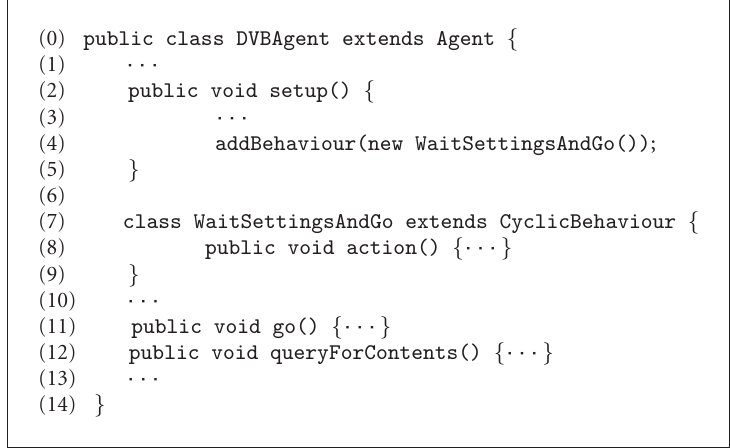
Figure 3: Mobile agent implementation.